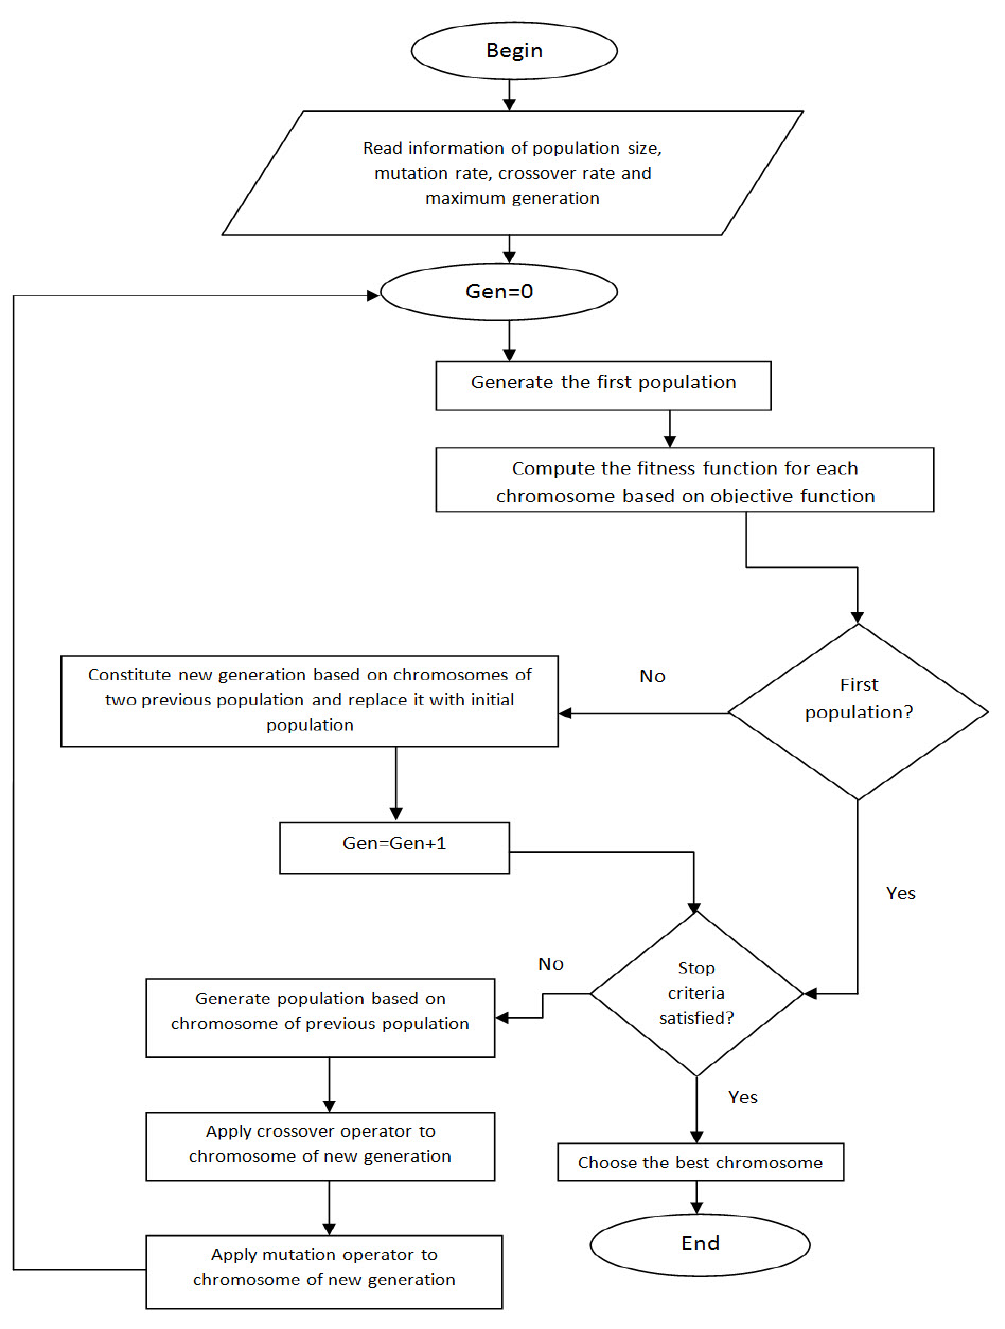
Figure 2. Schematic diagram of the Genetic Algorithm